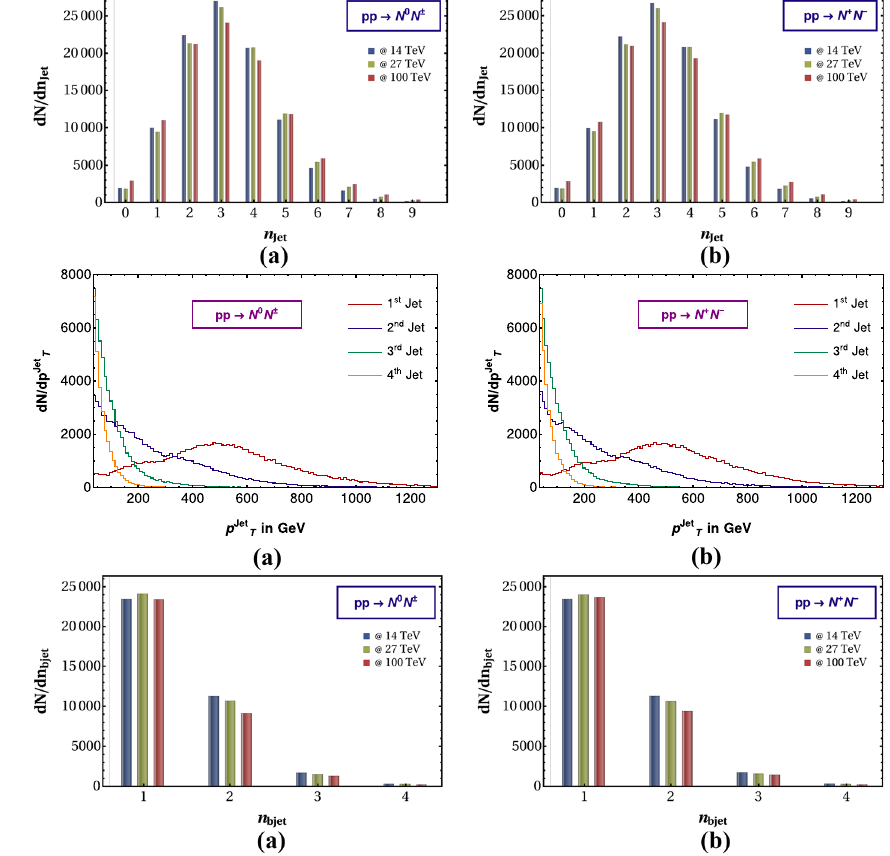
b represent the distributions of two leptons for pre and post jet-lepton isolation, respectively for B ( N ± → h e ± ) = 100%. c describes the scenario for the isolated leptons obeying the branching ratio of BP1